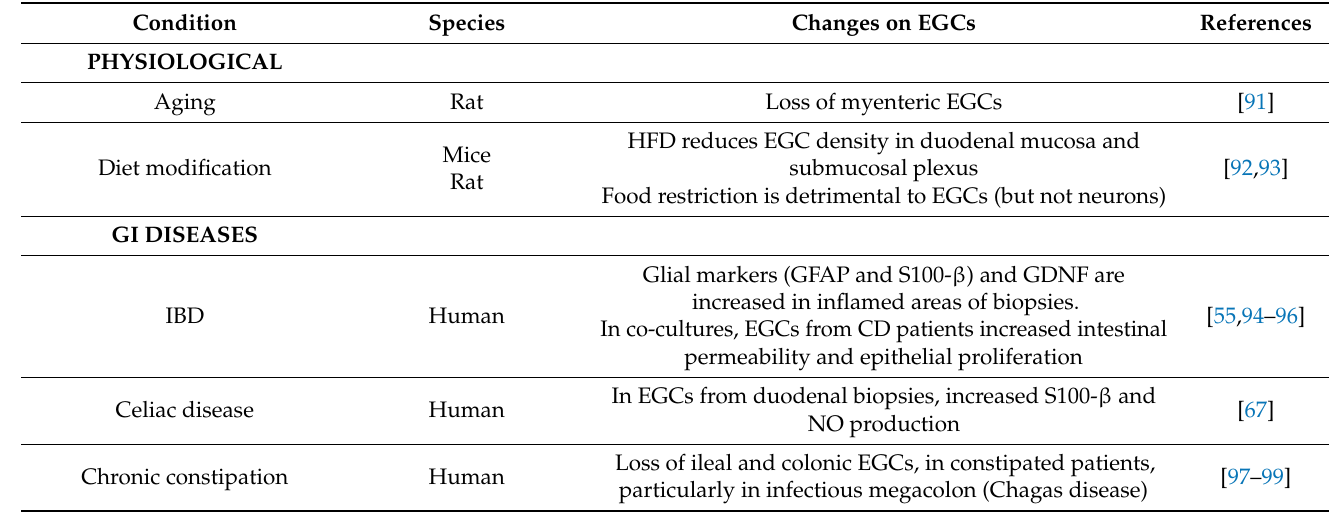
Table 2. Conditions affecting the gastrointestinal tract function for which a role of enteric glial cells has been described or